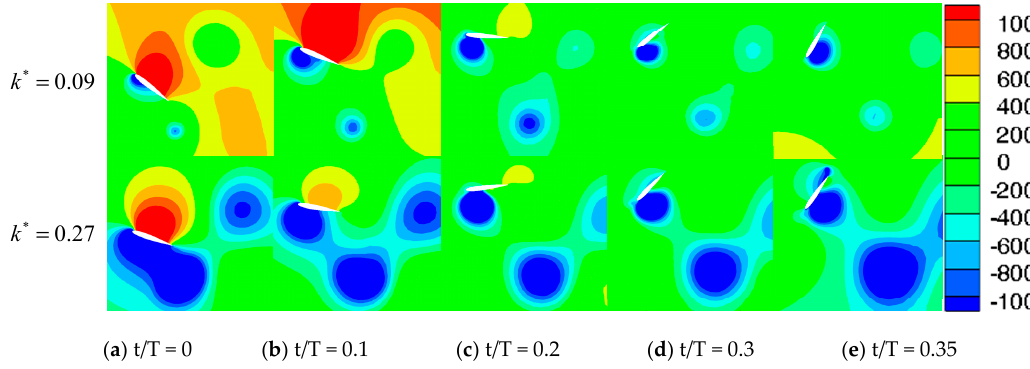
( b ) Figure 15. Evolution of (a) the thrust coefficient and (b) the pitching profile at 𝑘 ∗ = 0.09,0.27,0.37 , 𝑦 (cid:2868) = 0.2 , 𝑓 ∗ = 0.17 .